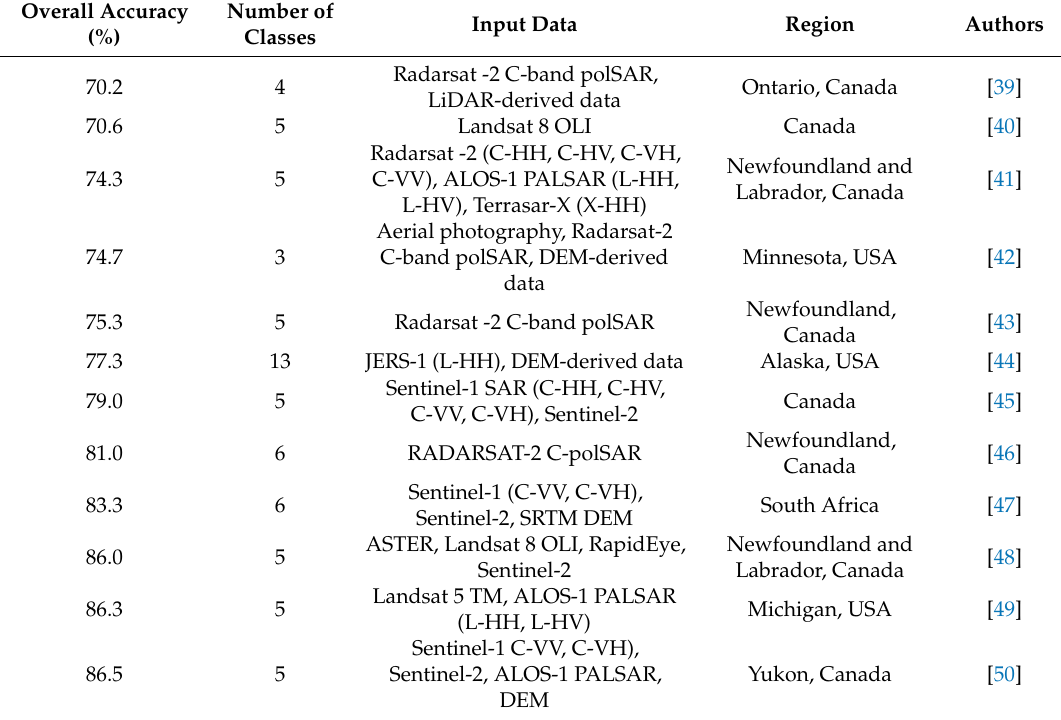
Table 1. Comparison of the best overall accuracy (%) achieved in previous studies that used Random Forests for wetland mapping, as a function of the number of classes and the input datasets. Overall